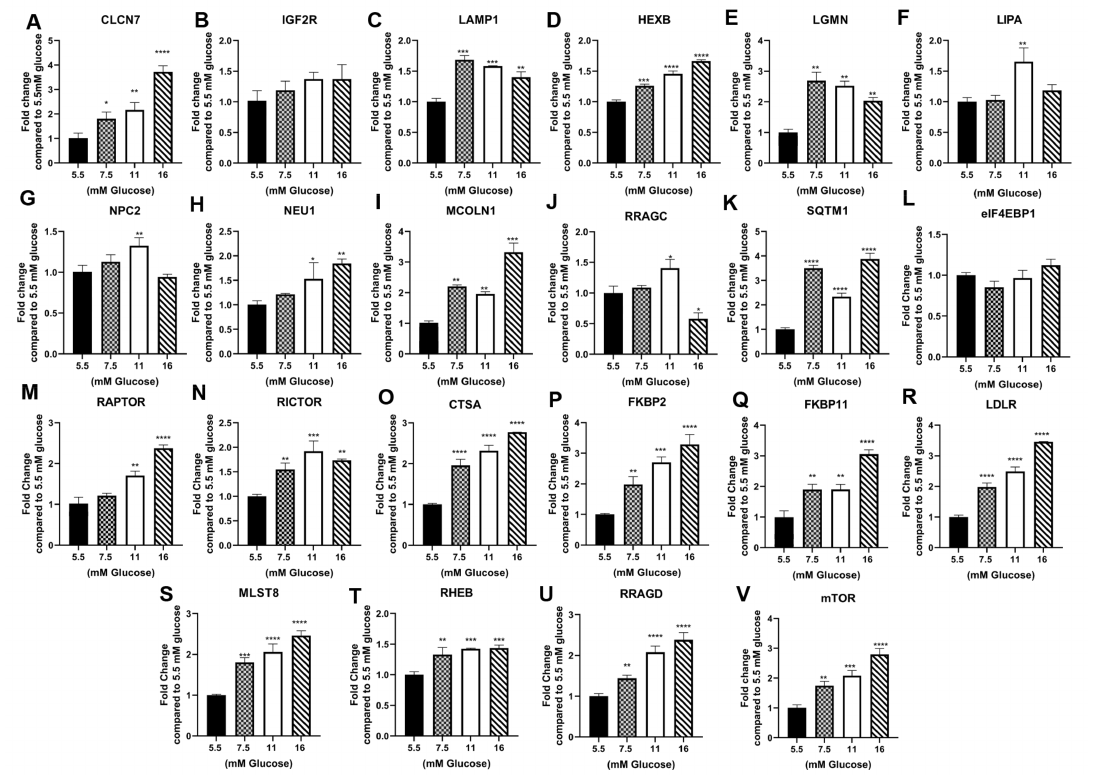
Figure 2. Expression of lysosomal and mTOR genes in HRTPT cells treated with 5.5 mM, 7.5 mM, 11 mM and 16 mM glucose for 10 passages. RT-qPCR analysis of ( A ) CLCN7; ( B ) IGF2R; ( C )